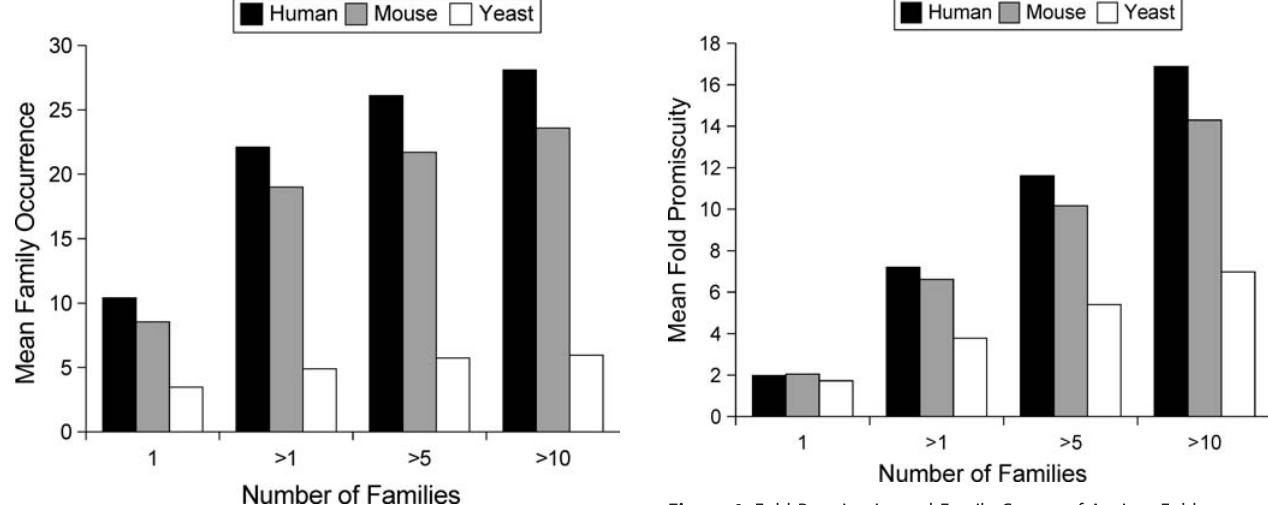
Figure 4. Fold Promiscuity and Family Counts of Ancient Folds Ancient SCOP folds were divided into a number of bins according to the number of families that they contain (x-axis). SCOP folds are connected to other ‘‘ partner ’’ folds in the same protein. The mean promiscuities (the number of unique partner folds a SCOP fold has) of folds in human, mouse and yeast are plotted. As the number of families in a SCOP fold increases, its promiscuity tends to increase. The differences in fold promiscuity between human, mouse, and yeast are larger for folds with larger numbers of families. All promiscuity differences described here between folds with one family and folds with more than one family are significant (MW-test, KS-test: p , 0.02). DOI: